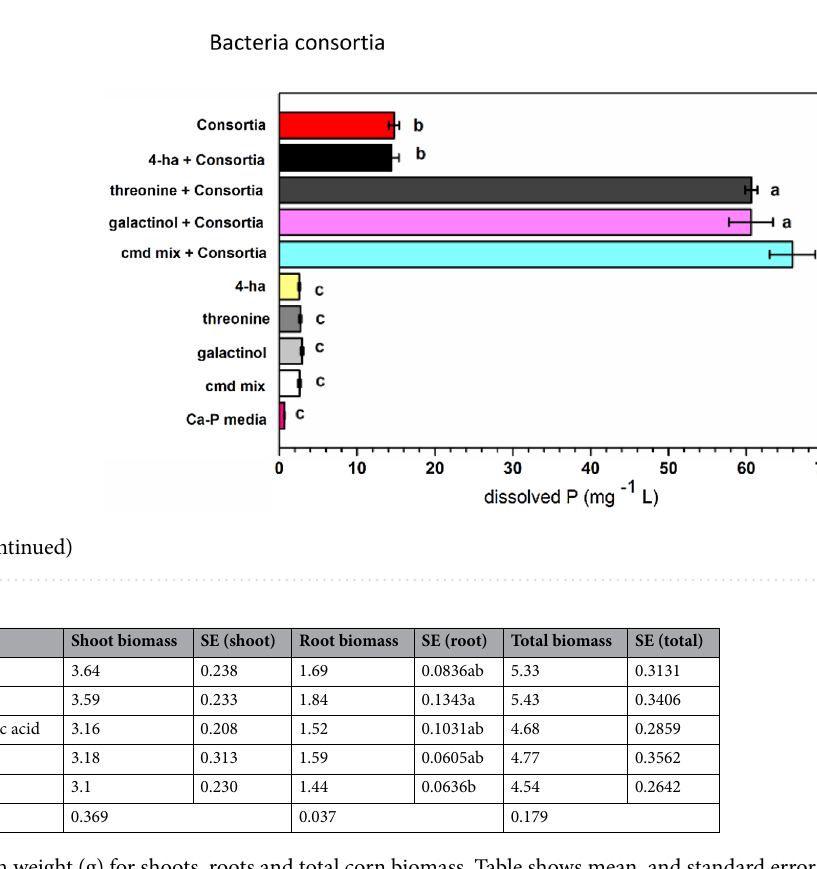
Table 1. Fresh weight (g) for shoots, roots and total corn biomass. Table shows mean, and standard error (se) calculated from 10 replicates per treatment. A one-way ANOVA was performed to compare the effect of root exudates on bacteria. Tukey’s HSD test for multiple comparisons show significant differences. Different letters denote statistical significance among treatments ( p-value < 0.05).